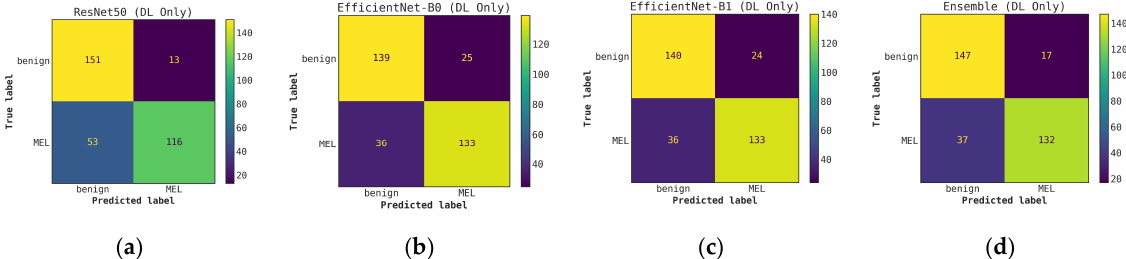
Figure A2. Comparison of confusion matrices for conventional classifiers using only hand-crafted features for classification (without Cascade generalization) on the classification hold-out test set. ( a ) Neural network; ( b ) RBF SVM; ( c ) Linear SVM; ( d ) Random Forest; ( e ) Decision Tree; ( f ) Ensemble of conventional models.